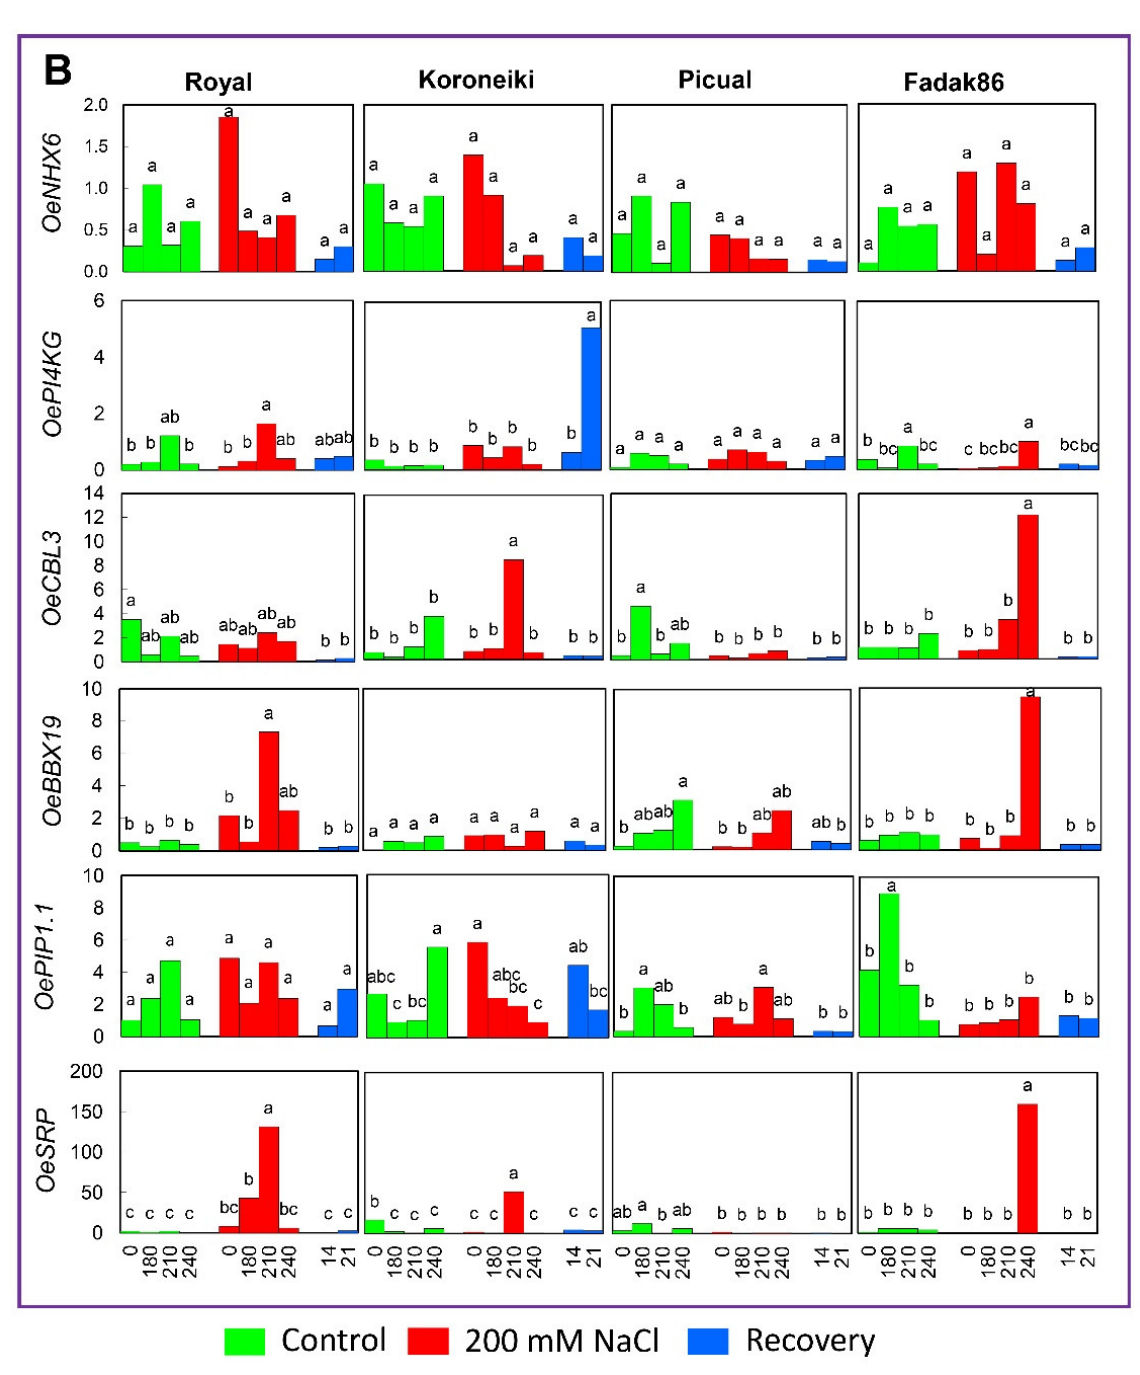
Figure 5. Gene expression under salt stress, as determined by RT-qPCR. ( A ) Genes highly expressed in tolerant olive cultivars. ( B ) differentially expressed genes in tolerant and susceptible cultivars. Leaves of plants under control conditions or treated at 200 mM NaCl were analyzed at time point 0, 180, 210 and 240 DATS. Plants in recovery at 14 and 21 DARS. Values are means of three biological replicates and three technical replicates. Different letters correspond to significantly different values at p ≤ 0.01.